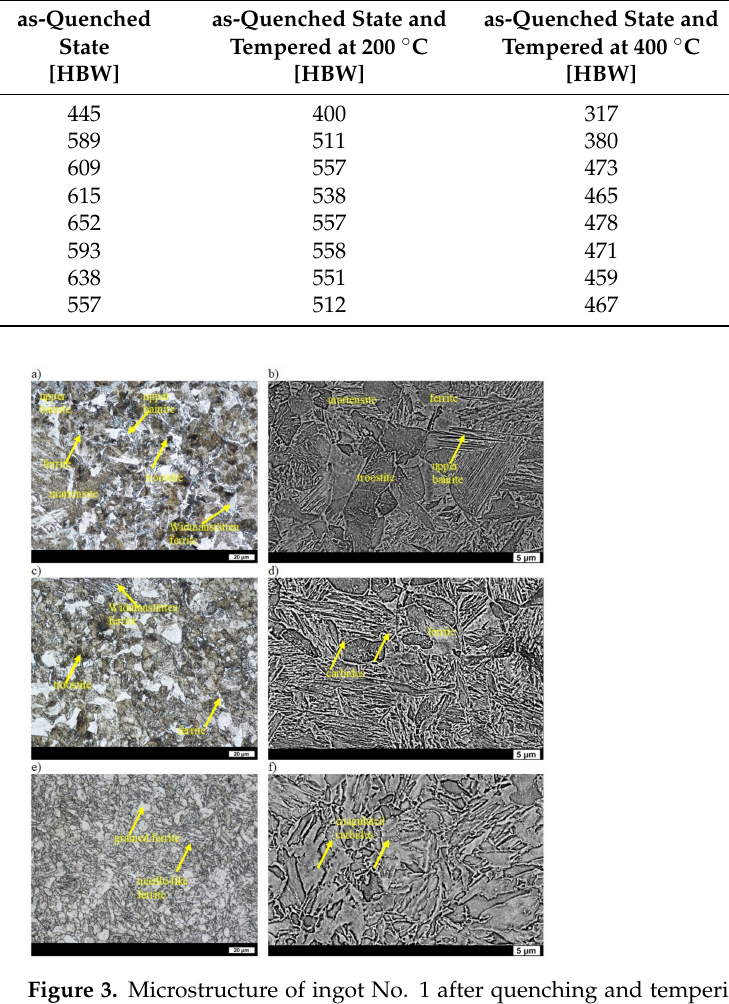
Figure 3. Microstructure of ingot No. 1 after quenching and tempering: ( a ) at 200 ◦ C, LM; ( b ) at 200 ◦ C, SEM; ( c ) at 400 ◦ C, LM; ( d ) at 400 ◦ C, SEM; ( e ) at 600 ◦ C, LM; ( f ) at 600 ◦ C, SEM. Etched with 3% HNO 3